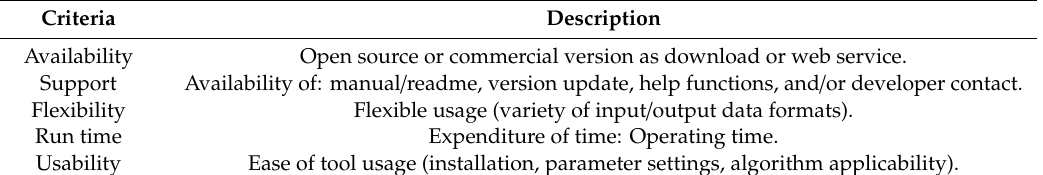
Table 2. Criteria to select tools for metagenomics data analysis [37].